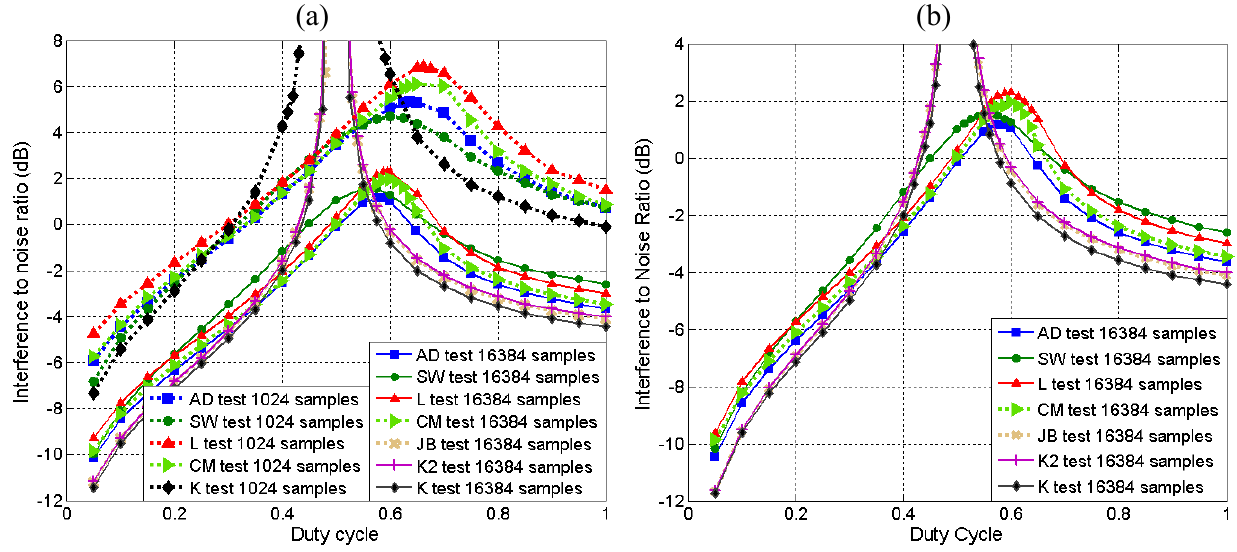
Figure 6. Normality test performance in the detection of a pulsed sinusoidal interference of 1,024 samples (dotted line) and 16,384 samples (solid line) (Figure 6a), and a chirp signal of 16,384 samples (Figure 6b) as a function of signal’s duty cycle. Both graphs represent the INR value required to obtain a ROC curve with a P = 0.1 for P = 0.9. SW fa det test has the best performance around duty cycle = 0.5, followed by AD test for 1,024 samples, while AD tests presents the best performance for 16,384 samples since SW test performance is degraded due to averaging. For low or high duty cycles the K test outperforms. JB and K2 tests results can not be used with 1,024 samples. Parameters f and 0 φ are selected at random for the pulsed sinusoidal interference, while are defined as 0 f = 2 × 10 − 5 and f = 0.15 with N =16,384; and φ = 0° for the pulsed chirp interference. 0 N 0 Results obtained from a Monte-Carlo set of 2 15